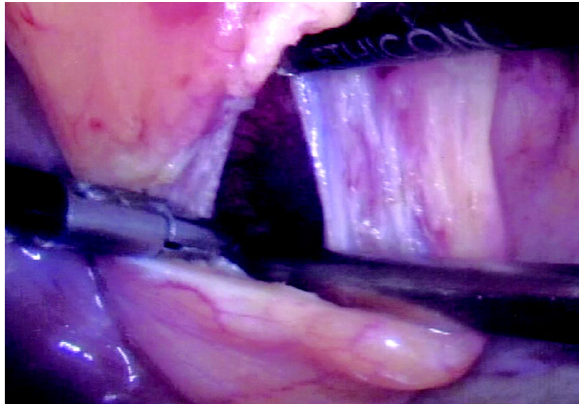
Figure 2 – Cystotomy for intravesical inspection with optics. Note that the bladder is distended by gas, since the Foley cath- eter is clamped, making this surgical step easier.